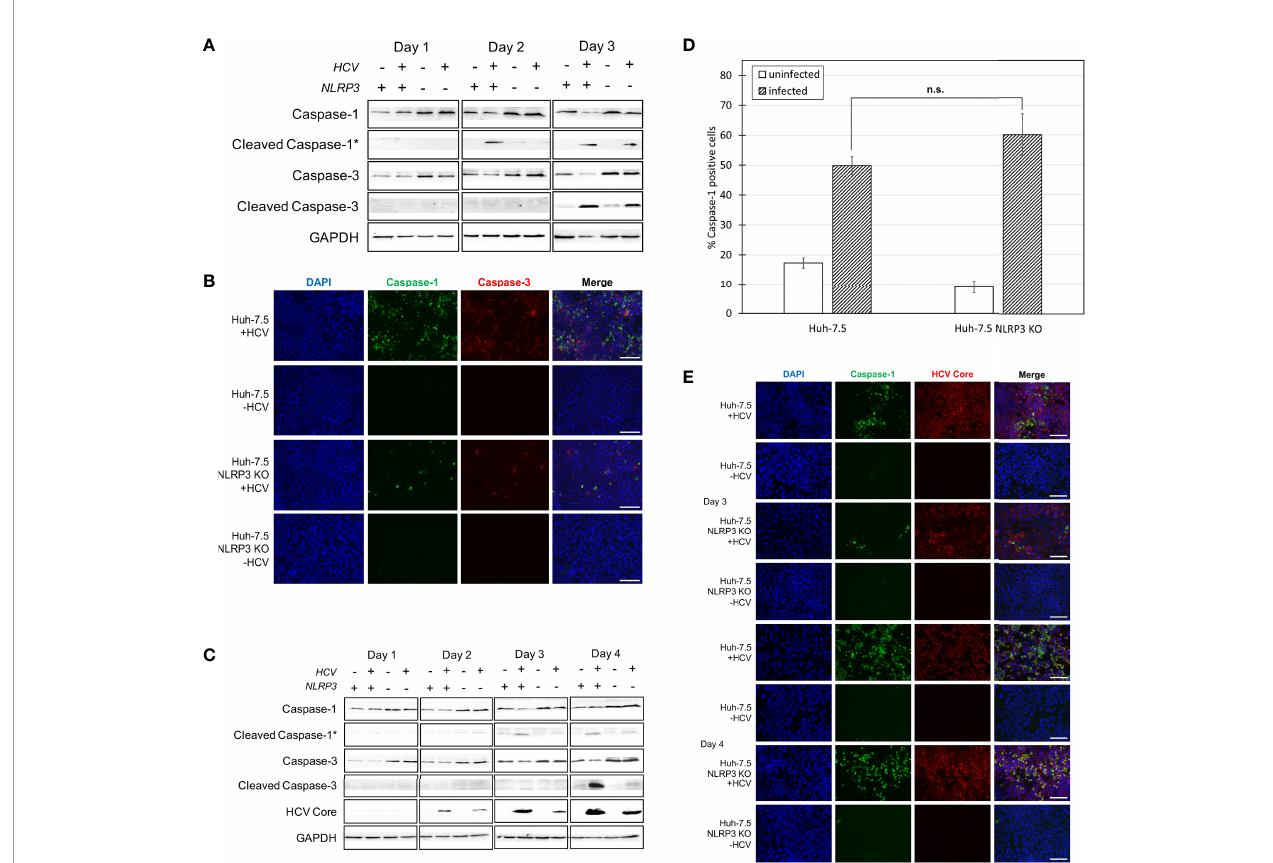
FIGURE 2 | Caspase-1 and -3 activation in Huh-7.5 cells and Huh-7.5 NLRP3 KO cells. (A, B) Huh-7.5 cells or Huh-7.5 NLRP3 KO cells were infected with HCV at MOI = 1 or left uninfected. (A) At 1, 2, and 3 days p.i., cells and culture fl uids were harvested for Western Blot analysis. Membranes were probed for pro-caspase-1, cleaved-caspase-1, pro-caspase-3, cleaved-caspase-3, and GAPDH. * indicates samples from cell culture fl uids rather than cell lysates. (B) At 3 days p.i., cells were stained for cleaved caspase-1 (green) using a speci fi c probe then fi xed using acetone. Cells were subsequently stained using an antibody speci fi c for cleaved caspase-3 (red). Nuclei were stained with DAPI (blue) for analysis by fl uorescence microscopy. Scale bar, 100 m m (C) Huh-7.5 cells or Huh-7.5 NLRP3 KO cells were infected with HCV at MOI = 0.1 or left uninfected. At 1, 2, 3, and 4 days p.i., cells and culture fl uids were harvested for Western Blot analysis. Membranes were probed for pro-caspase-1, cleaved-caspase-1, pro-caspase-3, cleaved-caspase-3, HCV core protein, and GAPDH. * indicates samples from cell culture fl uids rather than cell lysates. (D) At day 4 p.i., cells were stained for cleaved caspase-1 using a speci fi c probe and fi xed using fi xative from the caspase-1 probe kit. Cells were run on a CytoFLEX fl ow cytometer and data were analyzed using Kaluza analysis software. Data from NLRP3 KO cells are compared here to data from wild-type cells found in Figure 1D . Data are presented as the percent of total cells positive for caspase-1. p = n.s. (E) At 3 and 4 days p.i., cells were stained for cleaved caspase-1 (green) using a speci fi c probe, then fi xed using acetone. Cells were subsequently stained using an antibody speci fi c for HCV core protein (red). Nuclei were stained with DAPI (blue) for analysis by fl uorescence microscopy. Scale bar, 100 m m (A – E) Data are representative of three independent